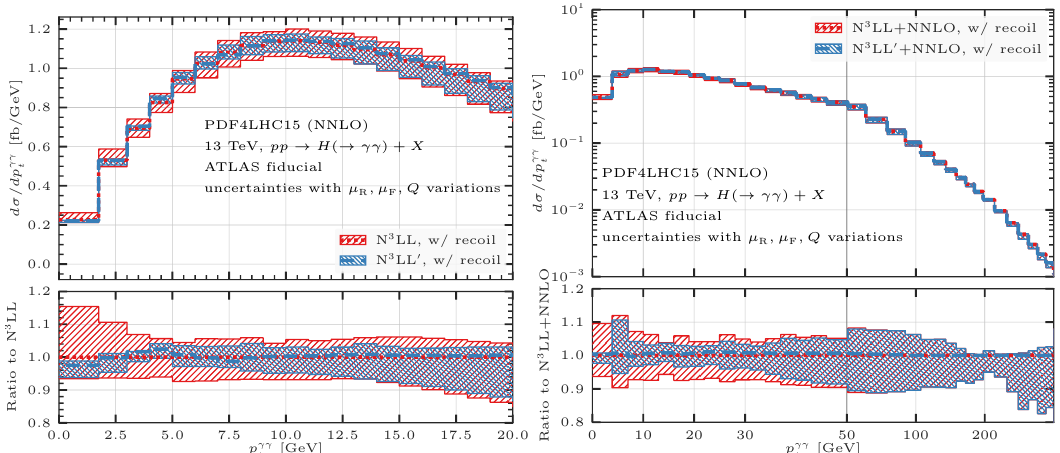
Figure 7 . Left: resummed predictions at N 3 LL (red) and N 3 LL 0 (blue) for p γγ ATLAS setup. Right: matched prediction at N 3 LL +NNLO (red) and N 3 LL 0 +NNLO (blue). In the right plot, the x axis is linear up to p γγ